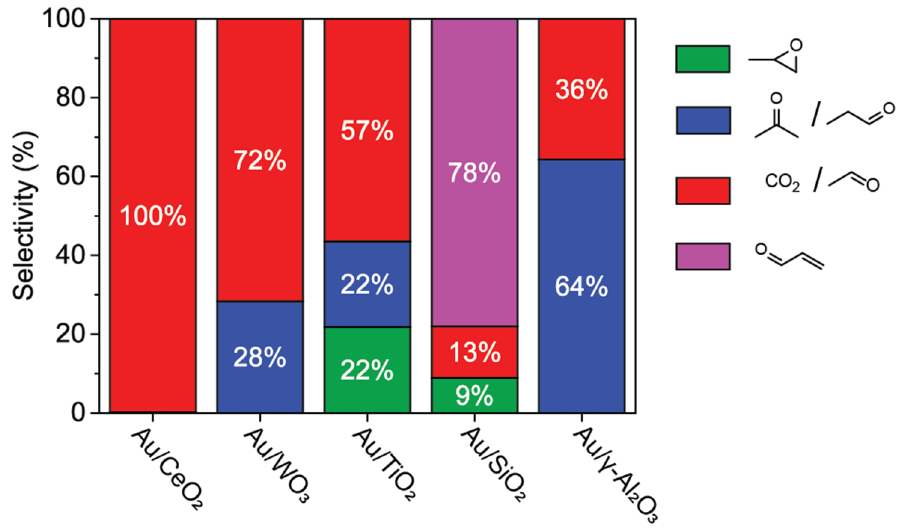
Figure 5. Selectivity during the oxidation of propene at 200 °C in the presence of hydrogen over supported gold catalysts. Conditions: 150 mg of catalyst, 10,000 mL/g cat /h flow of 10% of each C 3 H 6 , O 2 and H 2 in He at 200 °C. Only 25 mg of catalyst was used in the case of Au/CeO 2 .